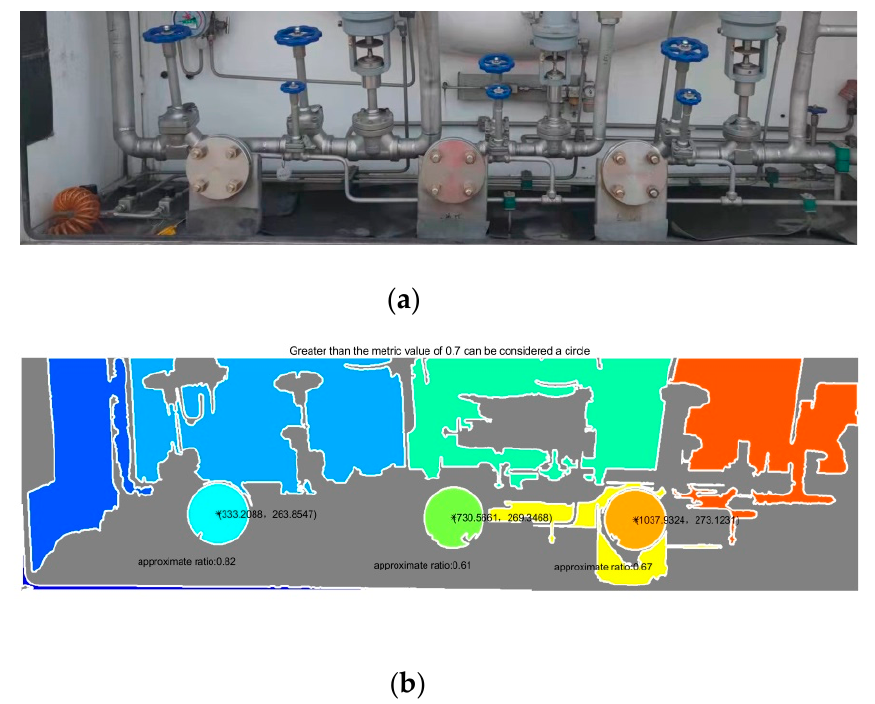
Figure 15. On-site tank car C. ( a ) Flange practicality picture. ( b ) Detection results of ( a ).